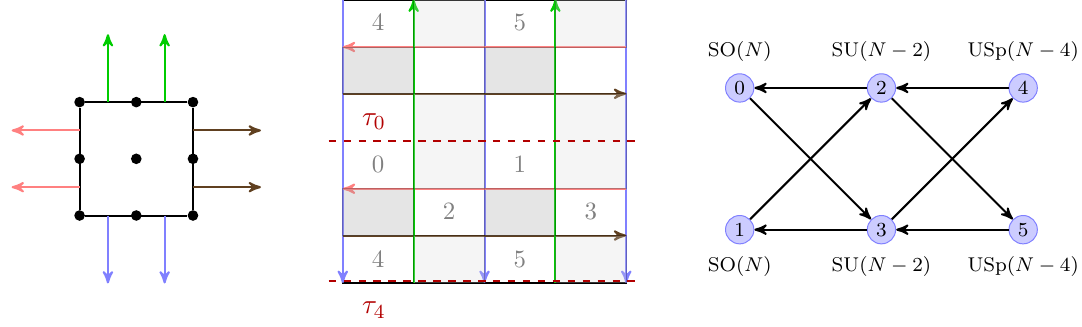
Figure 33. The model L 2 , 2 , 2 / Z 2 . On the left the toric diagram is drawn, at the center the five-brane and its orientifold with fixed lines, on the right the quiver resulting from the